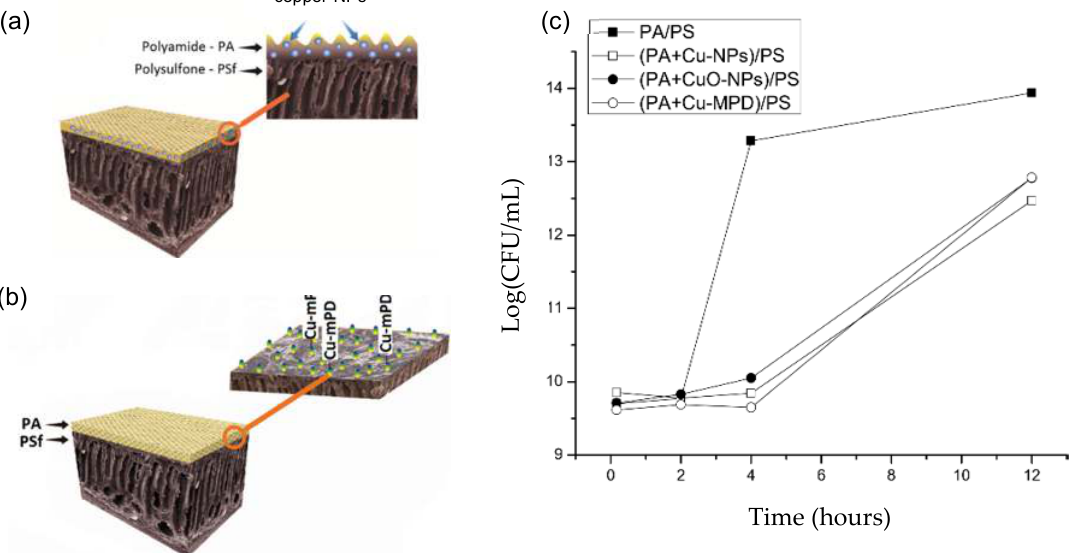
Figure 5. ( a ) Schematic of CuO-NPs addition to TFC-RO membranes during IPP and ( b ) of a TFC-RO membrane modified by formation of copper-oligomer complex (Cu-mPD) in situ. Extracted and adapted from [24]; ( c ) Bactericidal capacity (quantified by CFU) of copper modified membrane by addition in IPP of Cu-NPs, CuO-NPs and Cu-MPD compared to a pristine membrane (PA/PS). Extracted from [85].